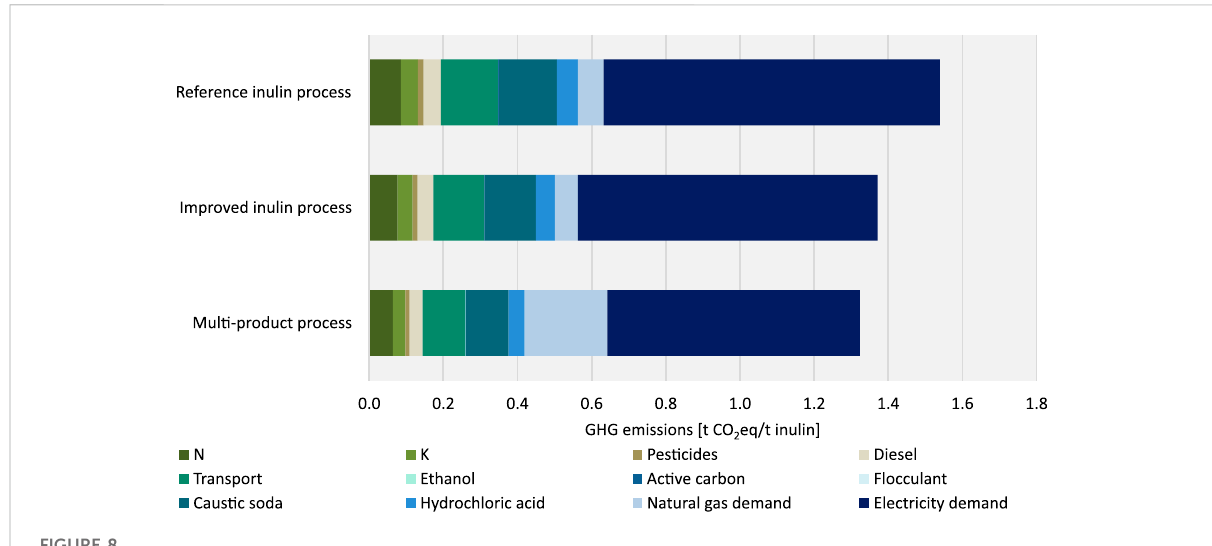
FIGURE 8 GHG emissions by auxiliary materials and auxiliary energy in cultivation and harvesting, transport and